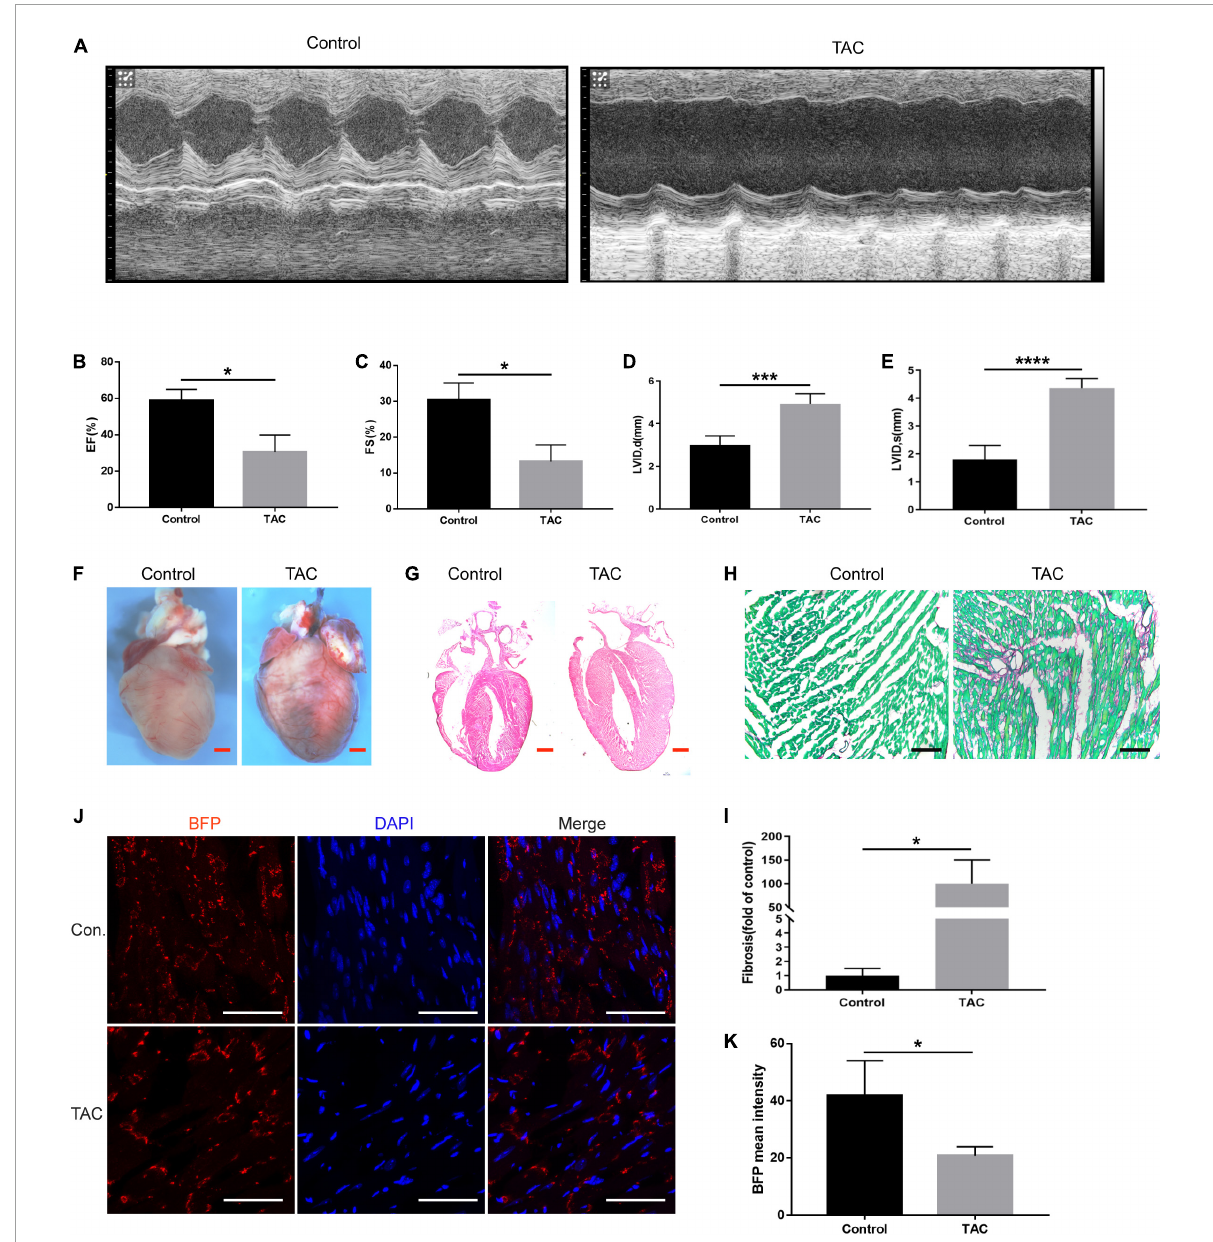
FIGURE6 Expression of Cx43 in cardiomyocytes of heart failure. (A) Representative M-mode echocardiograms in the control and TAC groups; EF (B) and FS (C) , LVIDd (D) , and LVIDs (E) changes in TAC mice evaluated by echocardiography, * P < 0.05, *** P < 0.001, **** P < 0.0001; (F) whole-mount bright field images of the heart in two groups; (G) HE staining of heart sections of normal mice and TAC-operated mice. (H,I) Sirius red staining of the heart sections of normal mice and TAC-operated mice and its quantification analysis, fast green as background color, * P < 0.05; (J) expression of BFP (red) in the myocardium of Cx43-BFP-GFP mice with heart failure. Red scale bar = 1 mm, black scale bar = 200 µ m, white scale bar = 100 µ m; (K) fading of BFP fluorescent intensity was observed in TAC mice, * P <